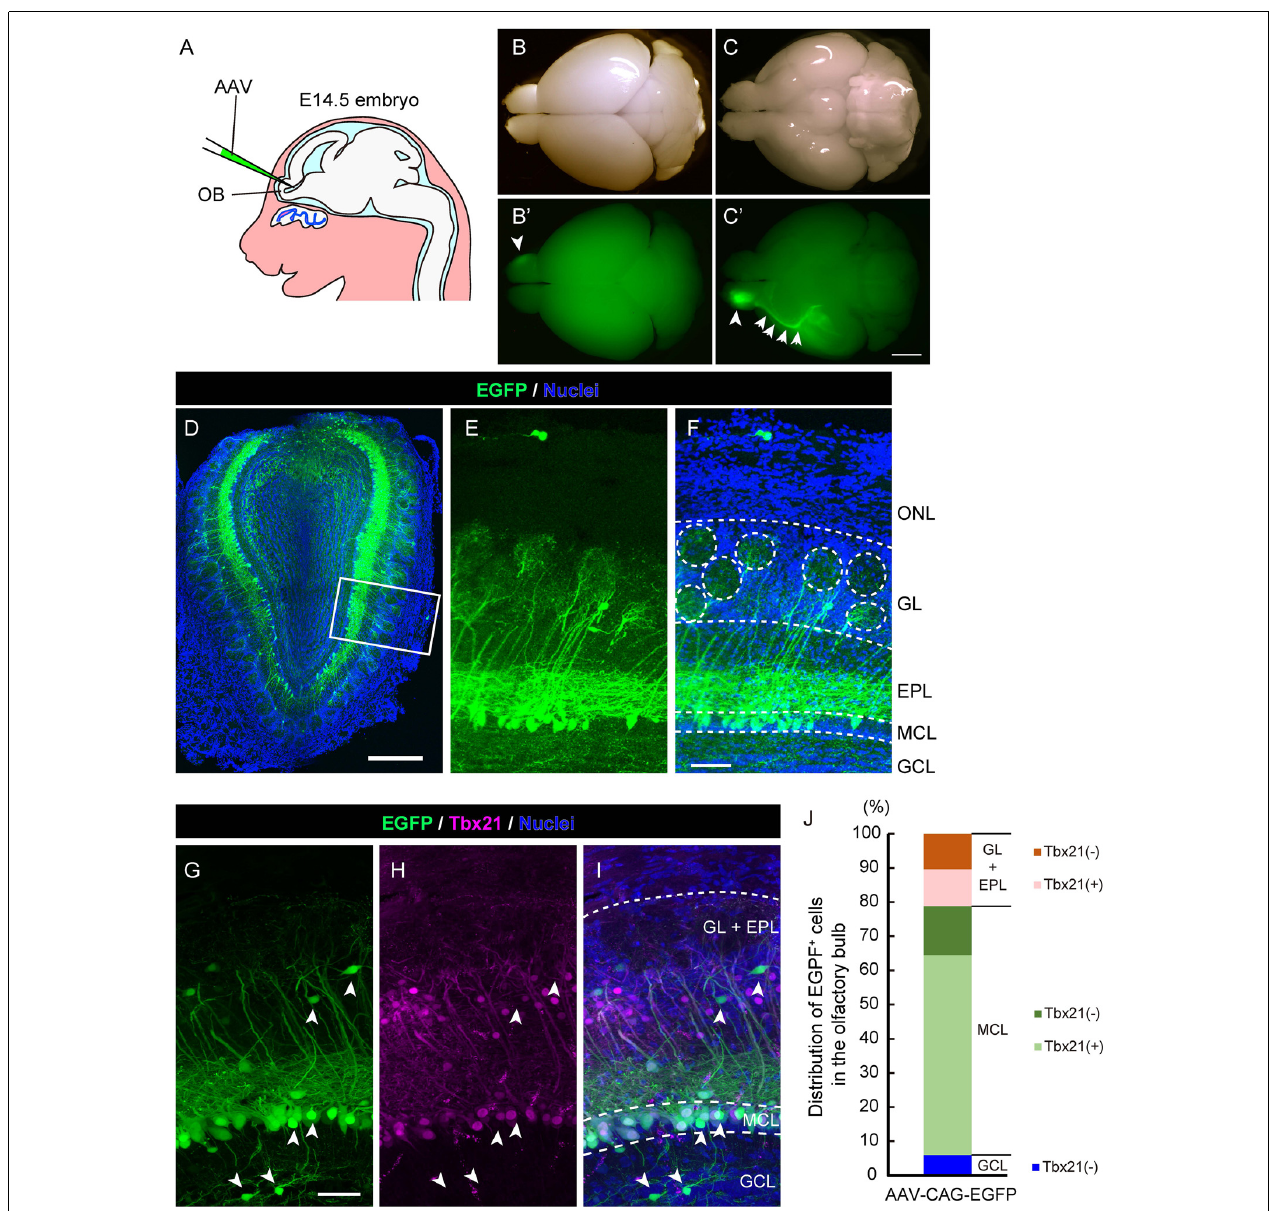
FIGURE 1 | Adeno-associated virus (AAV) injection into the olfactory ventricle preferentially labels mitral cells in the mouse olfactory bulb (OB). (A) A schematic view illustrating the way for AAV injection into the mouse embryonic olfactory ventricle using a glass microcapillary. (B,C) Photomicrographs show top (B) and bottom (C) views of an AAV-injected brain from a mouse at P14. The corresponding fluorescent images are shown in (B (cid:48) ) and (C (cid:48) ) . Scale bar, 2 mm. EGFP signal is observed not only in the right OB (arrowhead) but also in the axon bundle called the lateral olfactory tract (LOT; arrows). (D–F) A representative image of a coronal OB section from an AAV-injected mouse at 3 weeks of age. Scale bar, 500 µ m. The magnified image of the boxed area is shown in (E) and (F) . Scale bar, 100 µ m. The typical layer structure was visualized by nuclear staining shown in blue. ONL, olfactory nerve layer; GL, glomerular layer; EPL, external plexiform layer; MCL, mitral cell layer and GCL, granule cell layer. (G–I) The coronal section was immunostained with anti-GFP (green) and anti-Tbx21 (magenta), a marker for mitral cells in the OB, respectively. Scale bar, 50 µ m. EGFP-positive but Tbr21-negative cells are indicated by arrowheads. Based on nuclei and Tbx21 staining (G–I) , layers in the OB were divided into three parts; GL + EPL, MCL, and GCL. (J) Distribution of EGFP-positive cells in the OB. The numbers of EGFP-positive cells and EGFP-positive cells expressing Tbx21 were counted, and percentages of Tbx21-positive and Tbx21-negative/EGFP-positive cells among total EGFP-positive cells were calculated in each part. We counted 301 EGFP-positive cells from five mice (three males and two